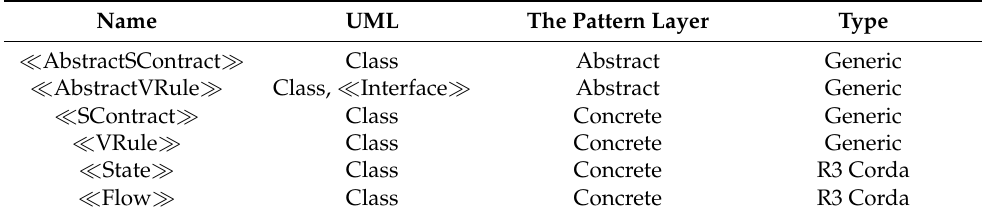
Figure 4. The UML profile diagram with platform-specific stereotypes for the R3 Corda. Table 2 contains a summary of platform-independent and platform-specific stereotypes in the profile with indicated UML classifiers, which are extended. The pattern layer, in which the stereotype is used, is also specified. Table 2. Stereotypes in the